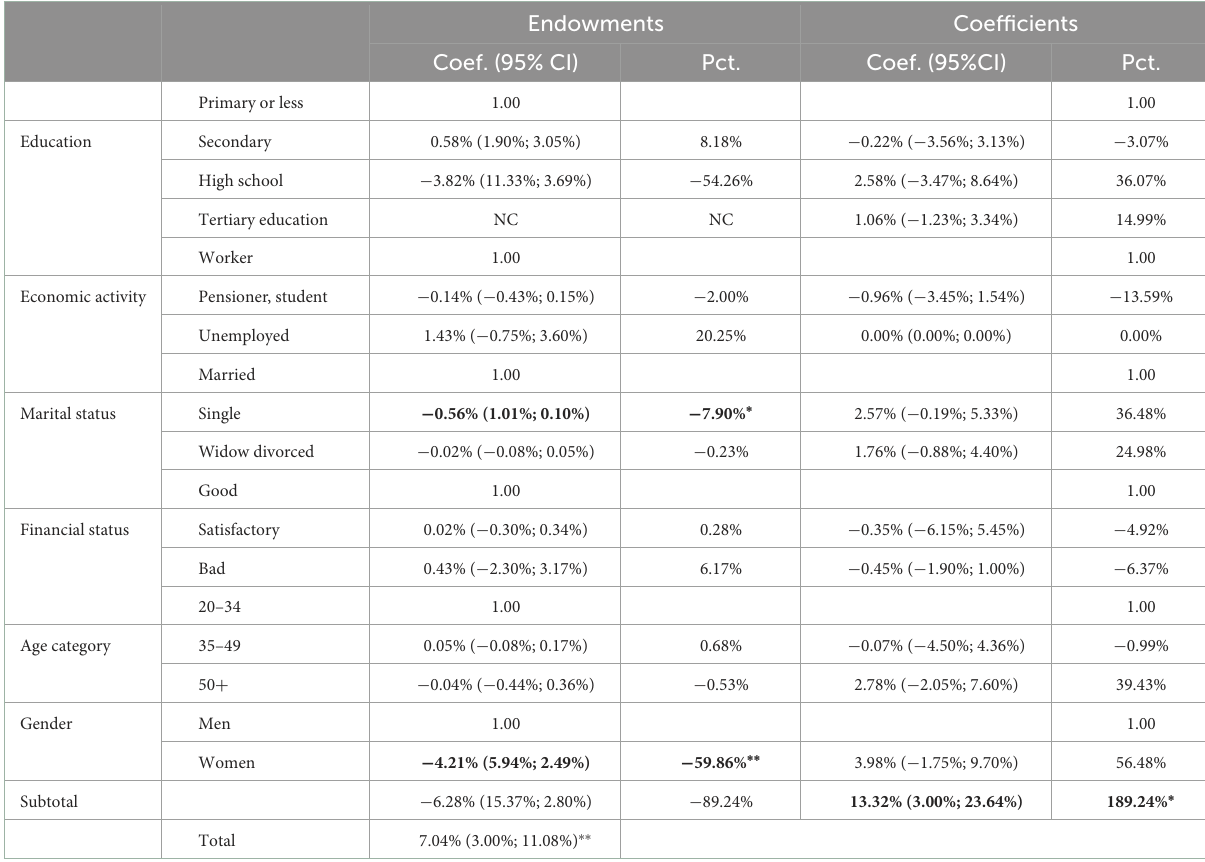
TABLE 6 Multivariate decomposition of the group (HG, HR) difference in alcohol-related harm.